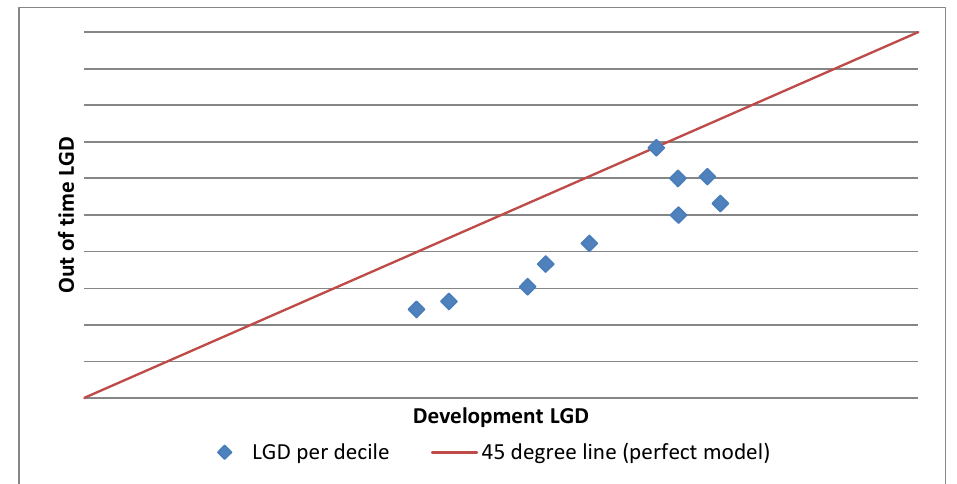
Figure 4. Comparison of the development and out of time LGD values.